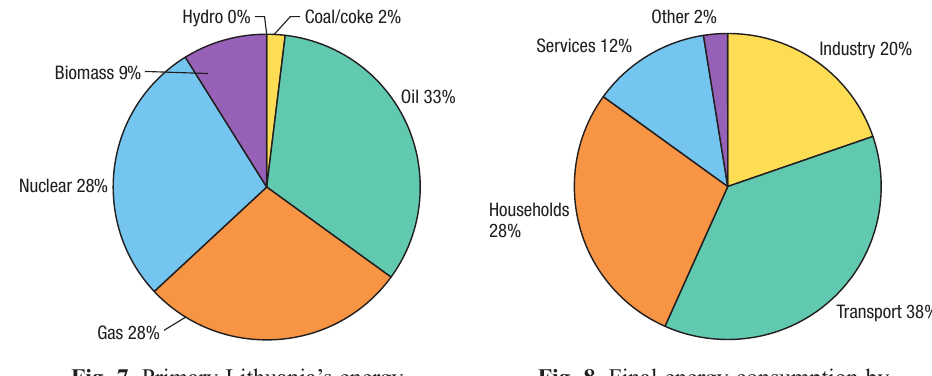
Fig. 7. Primary Lithuania’s energy Fig. 8. Final energy consumption